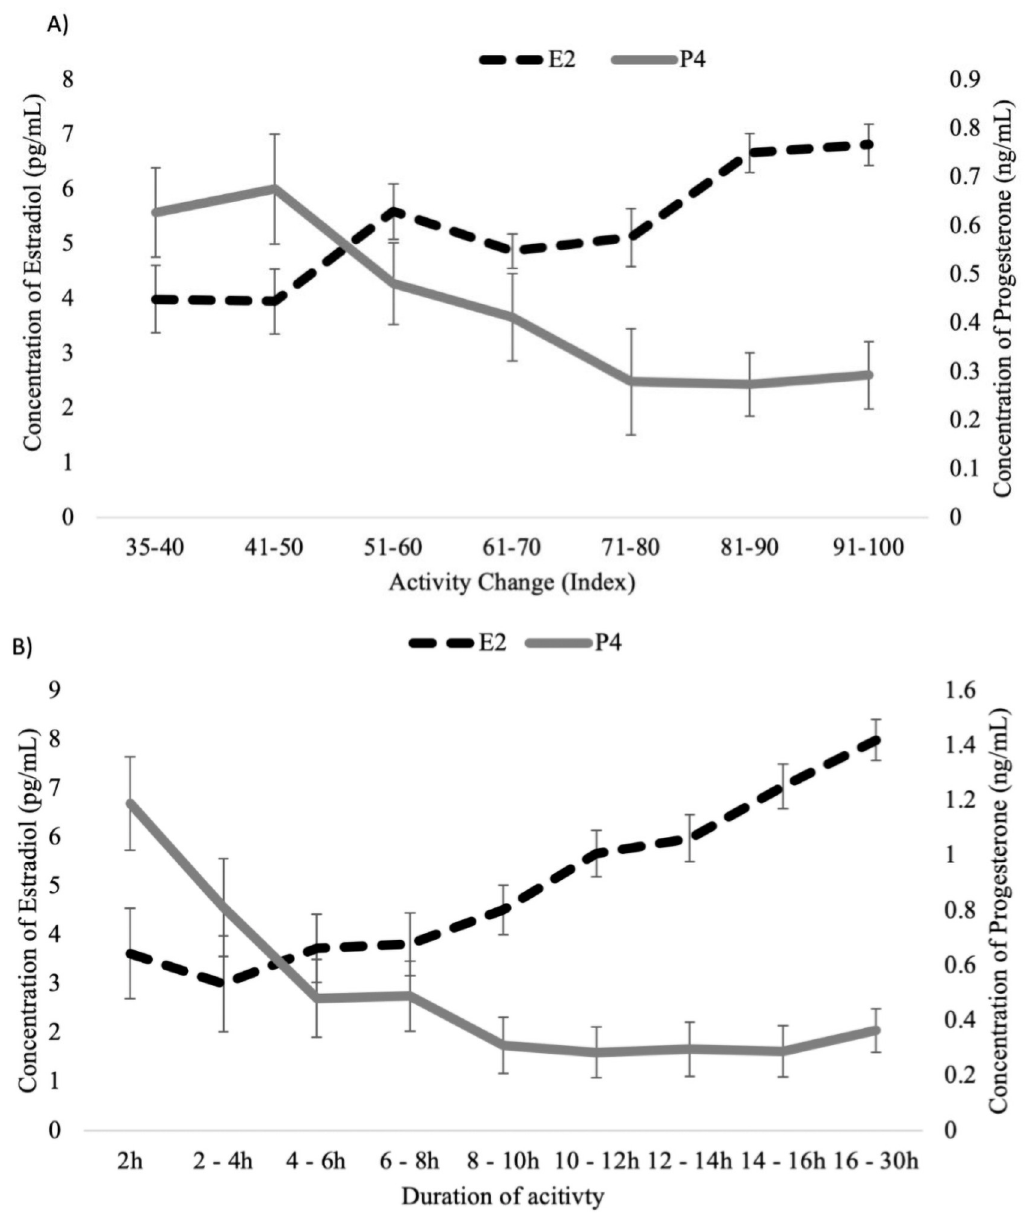
Fig 2. Distribution of increased estrous expression intensity (panel A) and duration (panel B) detected by a neck-mounted accelerometer at estrus and its association with the concentrations of progesterone and estradiol (least squares means ± SE) in Experiment